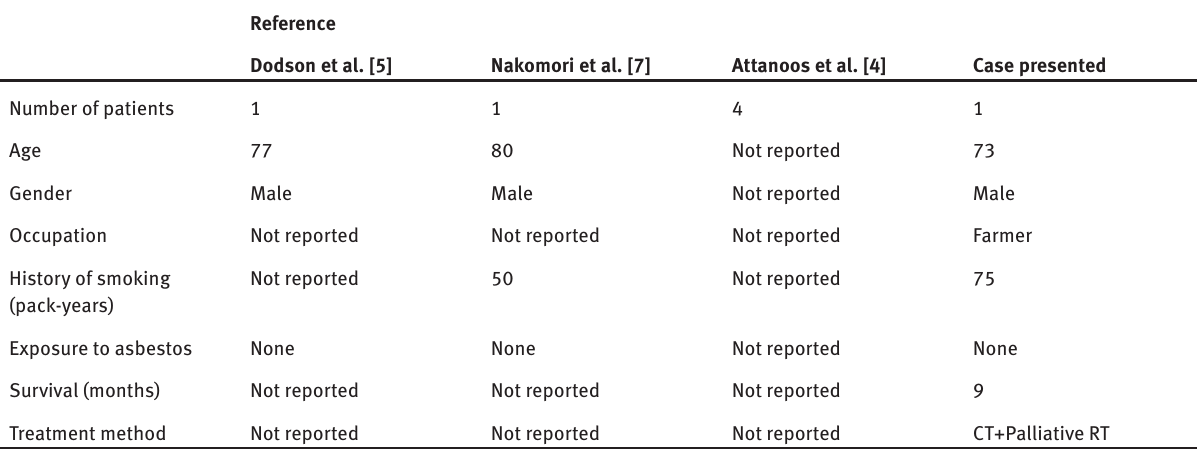
Table 1: Characteristics of pseudomesotheliomatous primary squamous cell lung cancer cases reported in the literature.